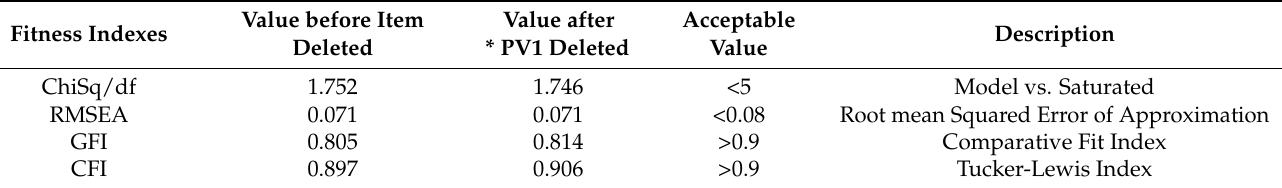
Table 5. The fitness of measurement model for the construct validity